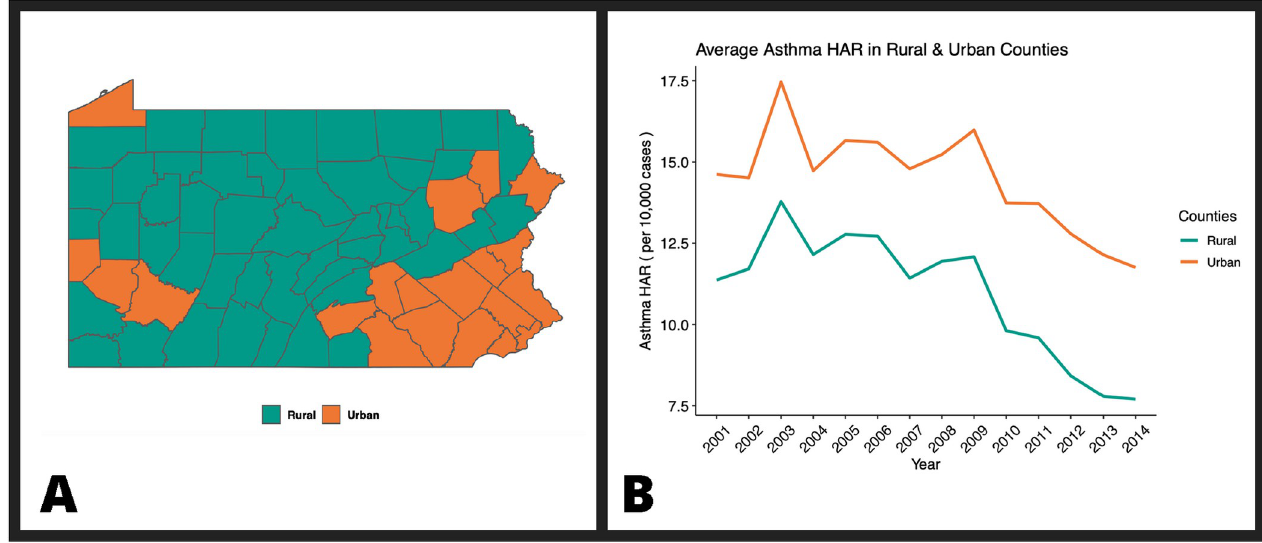
Fig 2. Comparison of annual average asthma hospitalization admission rates (HAR) in rural and urban counties of Pennsylvania. Panel A shows a map of Pennsylvania with counties designated as urban or rural as distinguished by the PA-DOH. The orange counties are those designated as urban, while the green represent counties that are rural. Panel B shows a line graph of the average asthma HAR per year from 2001–2014 for counties designated as rural and urban by the PA-DOH. The orange line represents the average asthma HAR per year for urban counties, while the green represents rural counties.